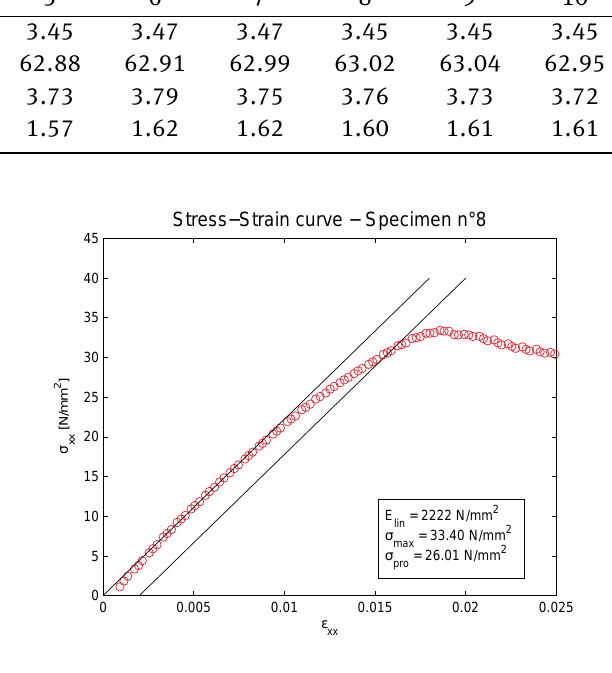
Figure 18: Actual stress-strain curve for specimen